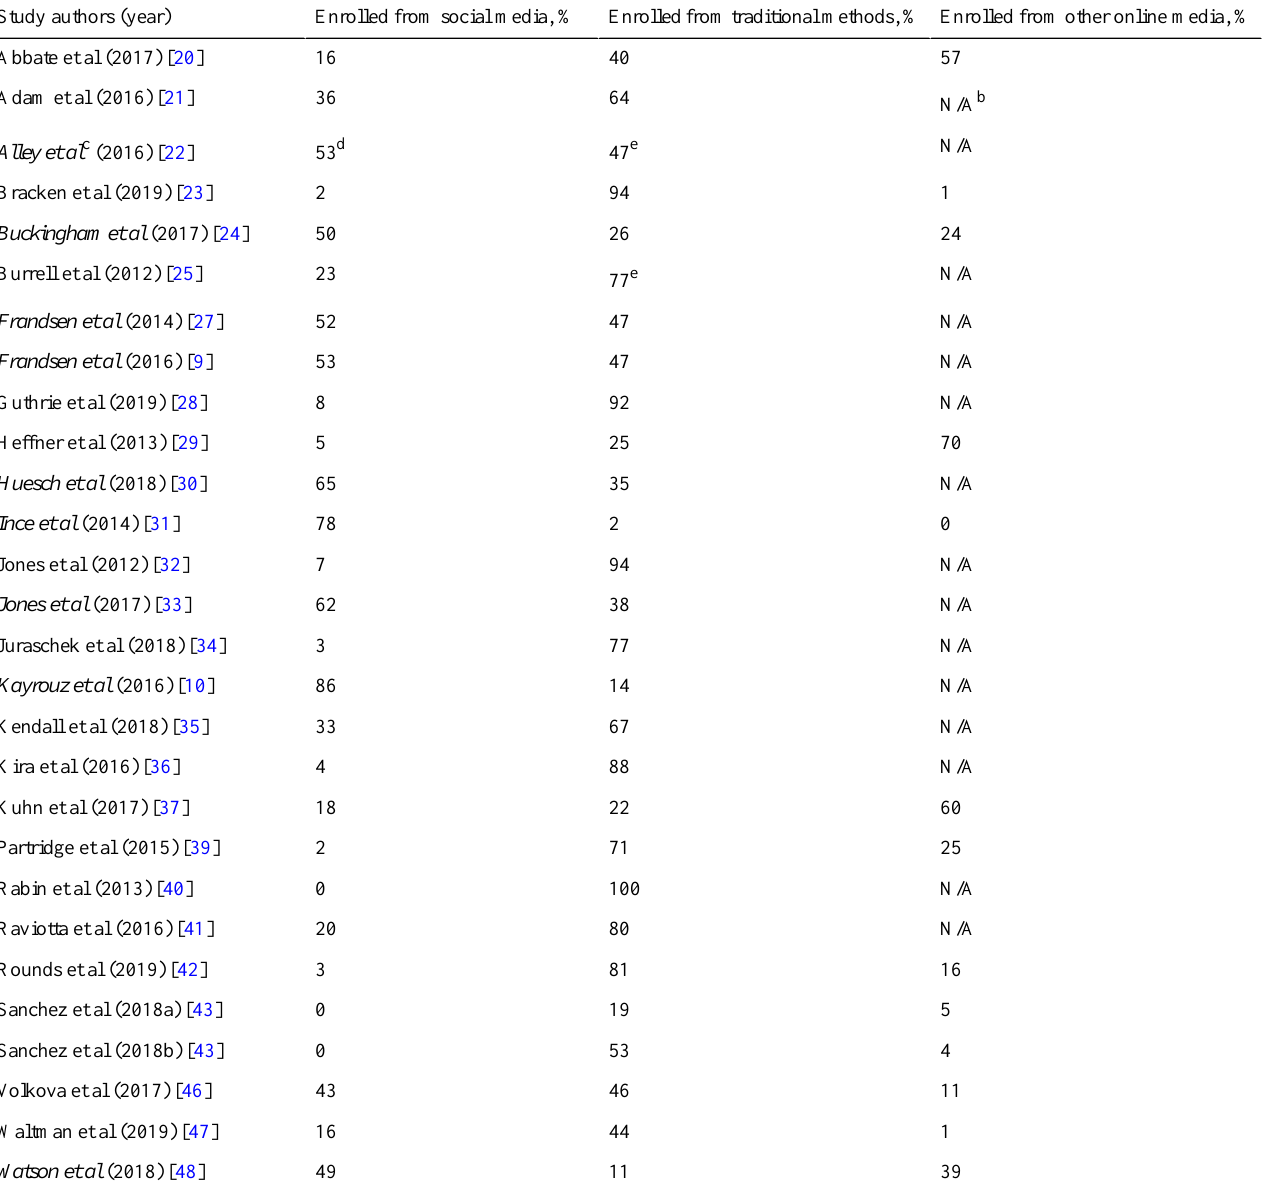
Table 4. Enrollment rates by recruitment method.